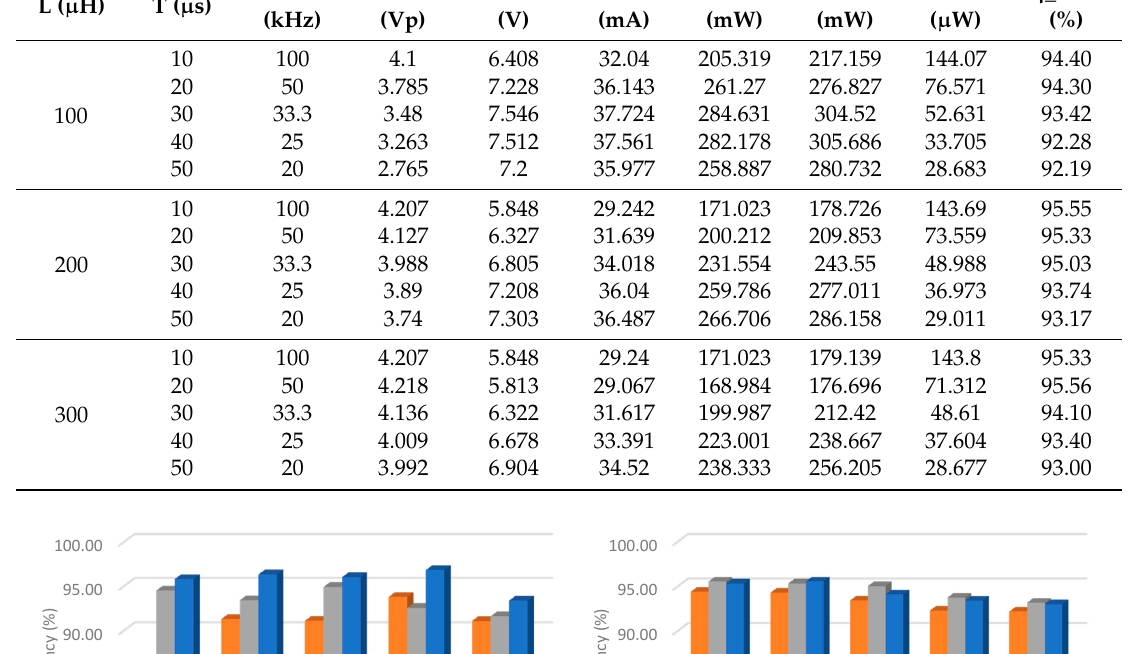
Table 9. Comparative results between different coils and frequencies at 1 sun and 60 °C.